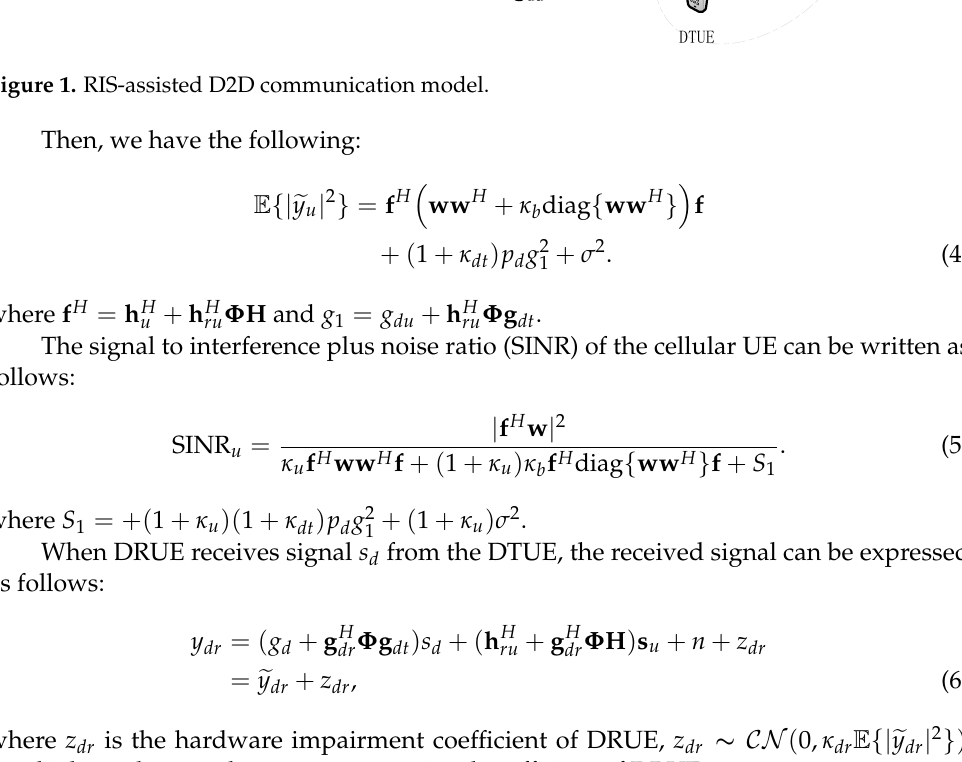
Figure 1. RIS-assisted D2D communication